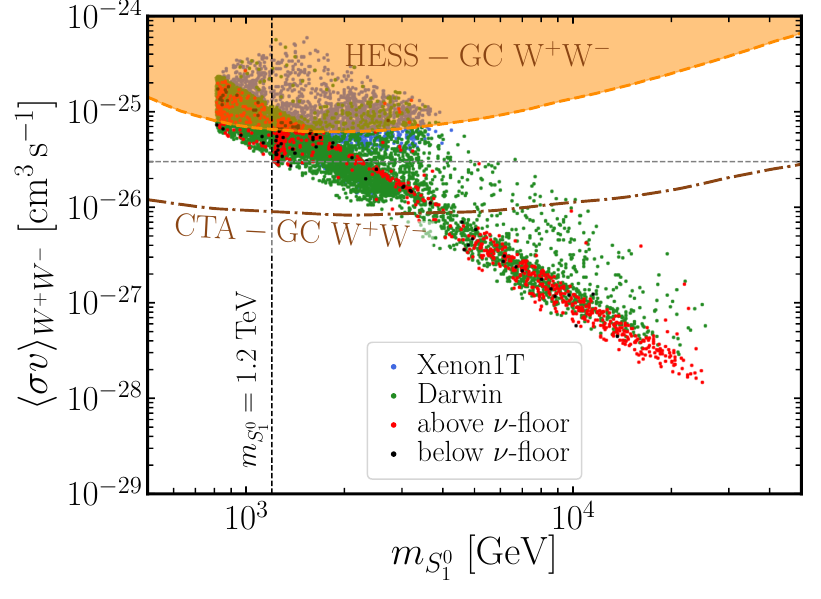
Figure 6 . Dark matter perturbative velocity averaged annihilation cross section into W + W − and constraints from HESS [48] as well as sensitivity prediction for CTA [49]. The various points represent the results from our scan in the parameter space reproducing both the correct dark matter relic density and neutrino masses. The color code is the same as in figure 5, as described in section